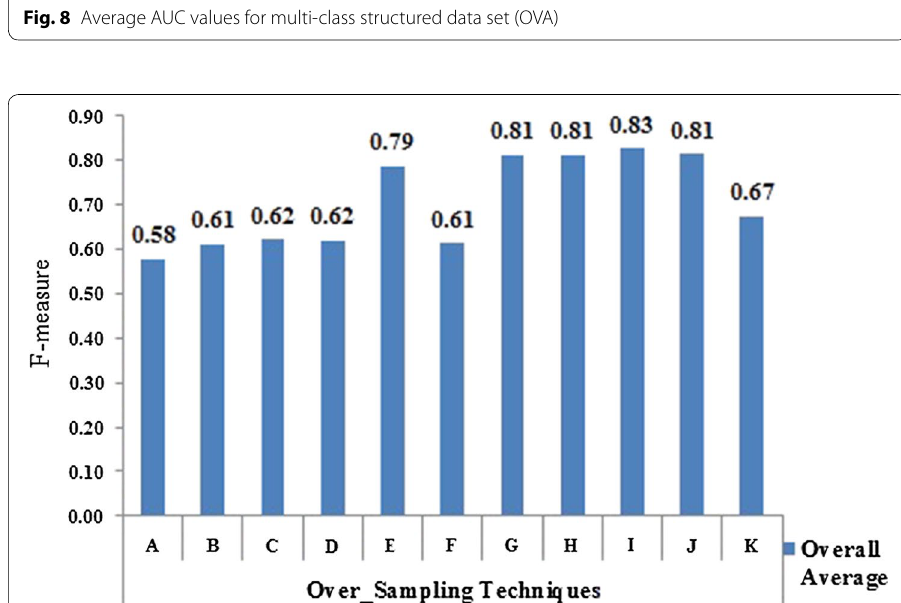
Fig. 9 Average F-measure values for binary class structured data